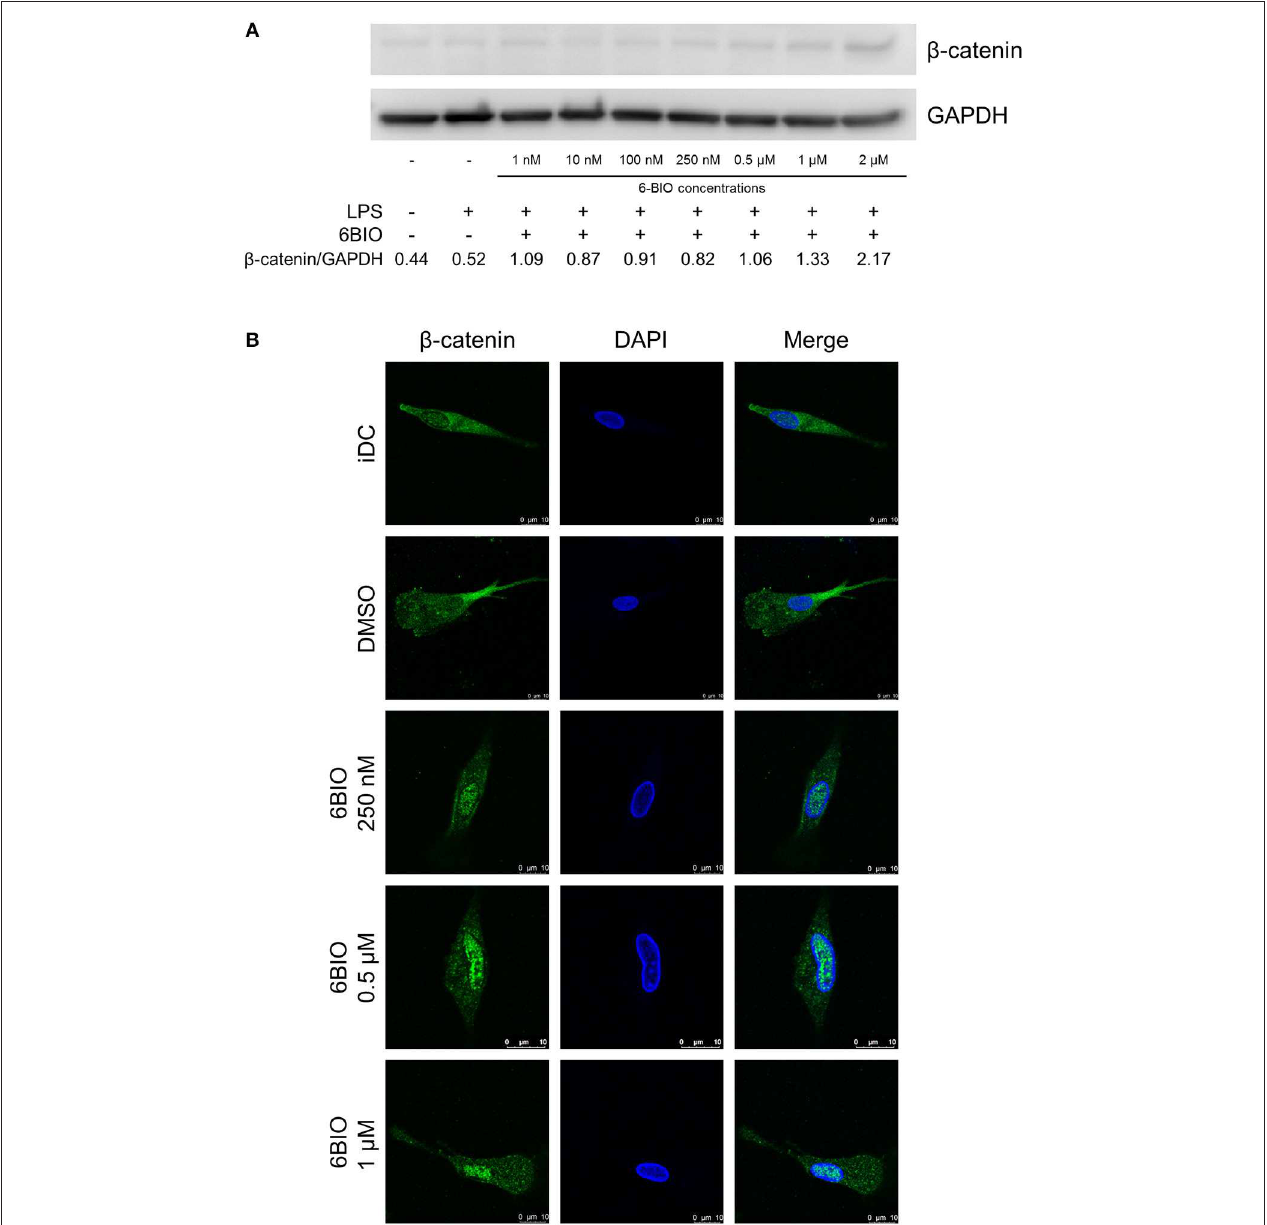
FIGURE 1 | Monocyte-derived dendritic cells (moDCs) obtained from healthy donors were treated with indicated concentrations of 6-bromoindirubin-3 ′ -oxime (6-BIO) or DMSO (vehicle) for 24h together with 30ng/ml of lipopolysaccharide (LPS) for the last 23h or left untreated as iDC. (A) β -catenin protein levels were measured by Western blot in whole-cell lysates. Representative Western blot of three independent experiments is shown. (B) Fluorescein (FITC) indirect immunofluorescent detection of β -catenin proteins according to confocal microscopy analyses.